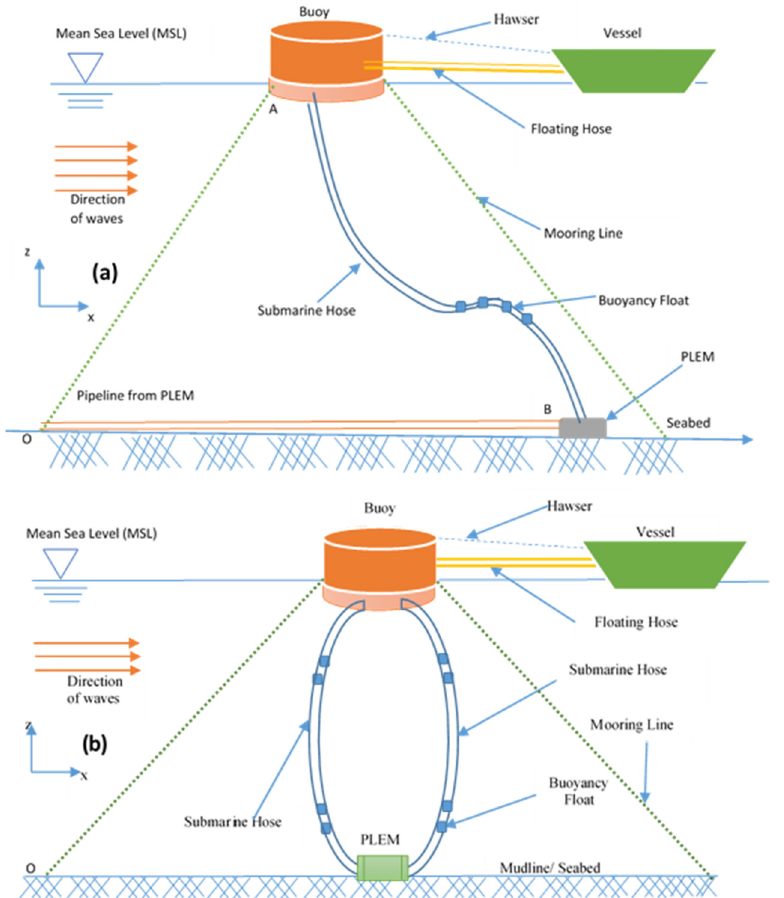
Figure 2. Sketch of the loading and offloading operation on a CALM buoy in ( a ) Lazy-S and ( b ) Chinese-Lantern configurations, with wave forces and boundary conditions.